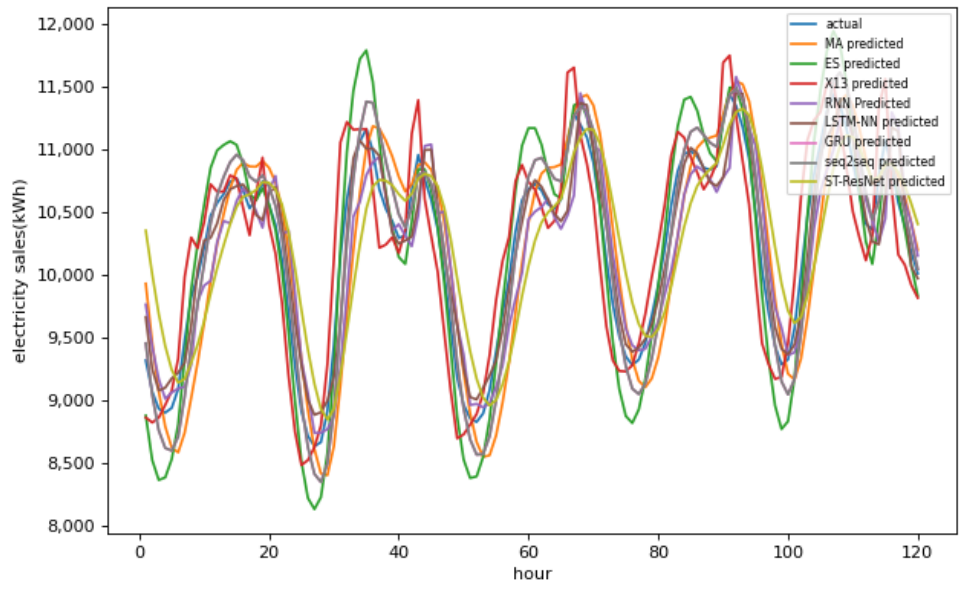
Figure 8. Comparison of ultra-short-term forecasting.